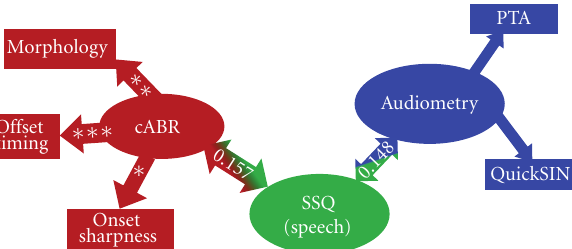
Figure 4: Self-perception of speech, assessed by the Speech Spatial Qualities Hearing scale (SSQ), is predicted by audiologic and cABR measures. The audiometric variables predict 15% of the variance in SSQ; the cABR variables predict an additional 16%. In the multiple linear regression model, only the contributions of the cABR onset time and morphology variables are significant. ∗ 𝑃 < 0.05 , ∗∗∗ 𝑃 < 0.01